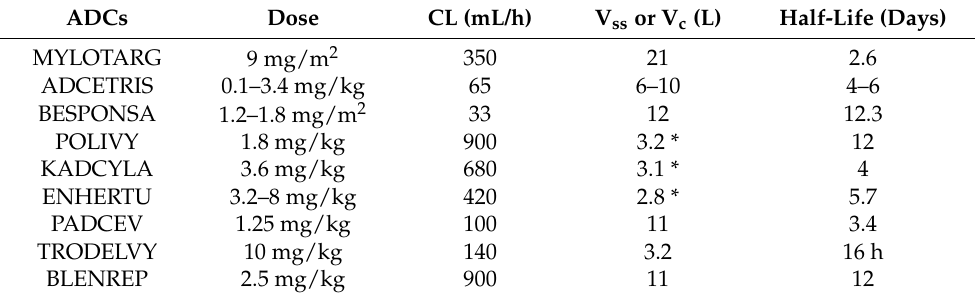
Table 2. Pharmacokinetic parameters of FDA approved ADCs (only the